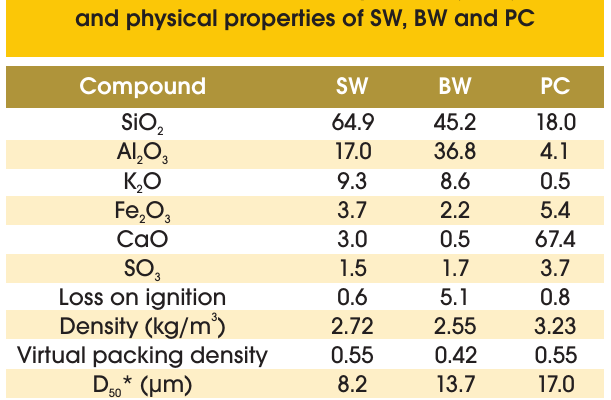
Figure 3 – X-ray diffraction pattern